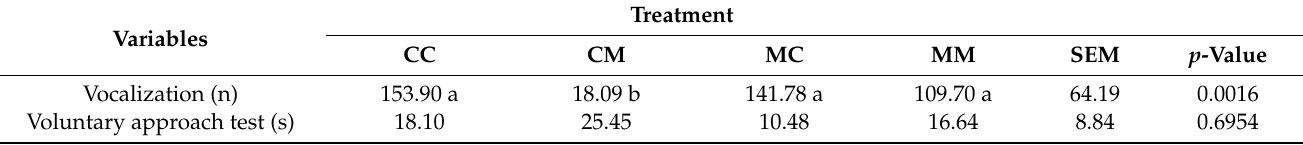
Table 3. Latency for a voluntary approach to humans (seconds) and the average number of vo- calizations of piglets distributed in the CC treatments: control-control; CM: control-music; MC: music-control; MM: